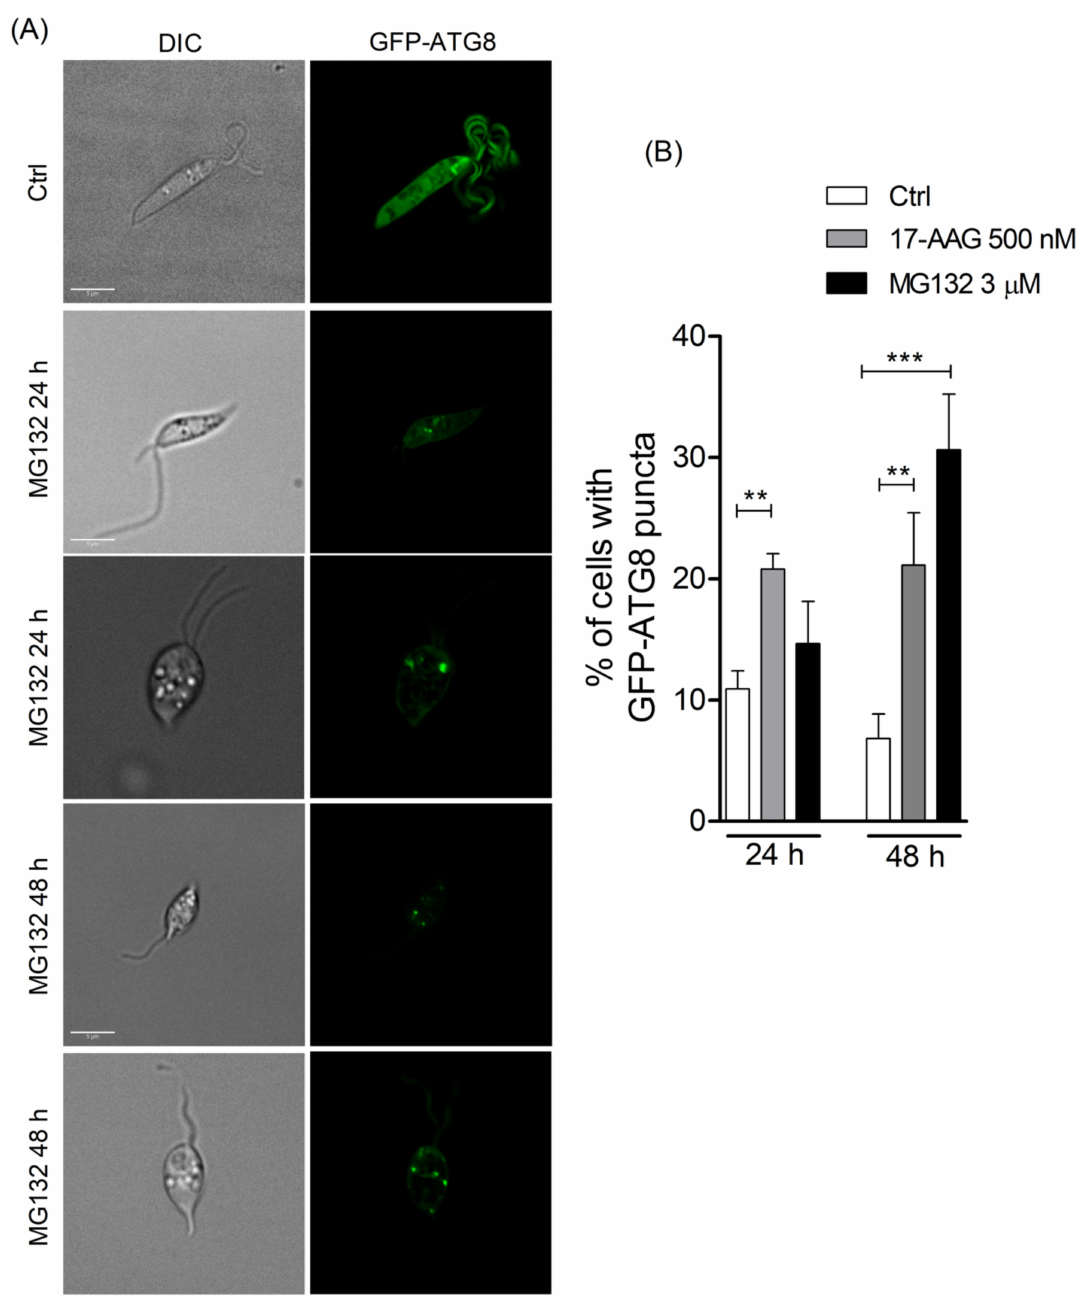
Figure 5. Evaluation of autophagosome formation in promastigotes of Leishmania following treatment with MG132. ( A ) Promastigotes of Leishmania expressing GFP-ATG8 were treated or not with MG132 (3 µ M) and imaged by fluorescence microscopy. ( B ) The percentage of cells bearing autophagosomes was calculated after treatment with 17-AAG (500 nM) or MG132 (3 µ M) for 24 and 48 h. Bars represent mean ± SD of three independent experiments (One-way ANOVA, Tukey’s multiple comparisons test, ** p < 0.01, *** p <